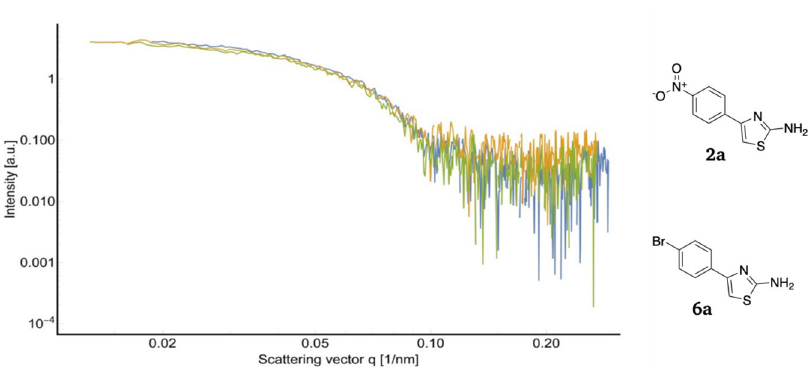
Fig. 6 Study of oligomeric fl uctuations of Pf MDH by characterization of its SAXS pro fi le. The overlay of scattering pro fi les from Pf MDH apoprotein (blue), Pf MDH in complex with compound 6a (orange) and compound 2a